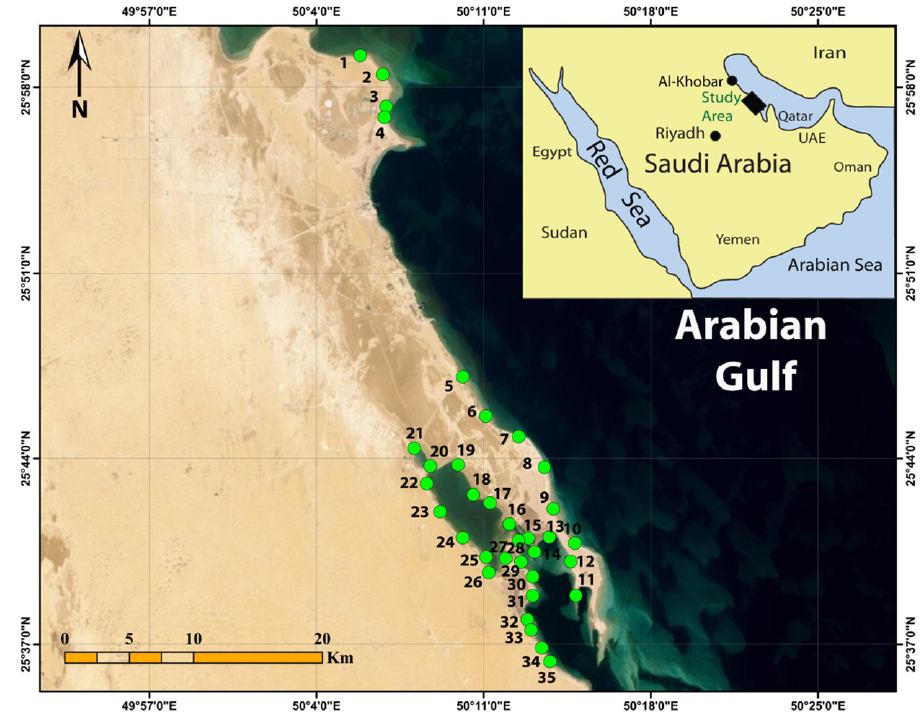
Figure 1. Study area map showing the locations of surface seawater samples.